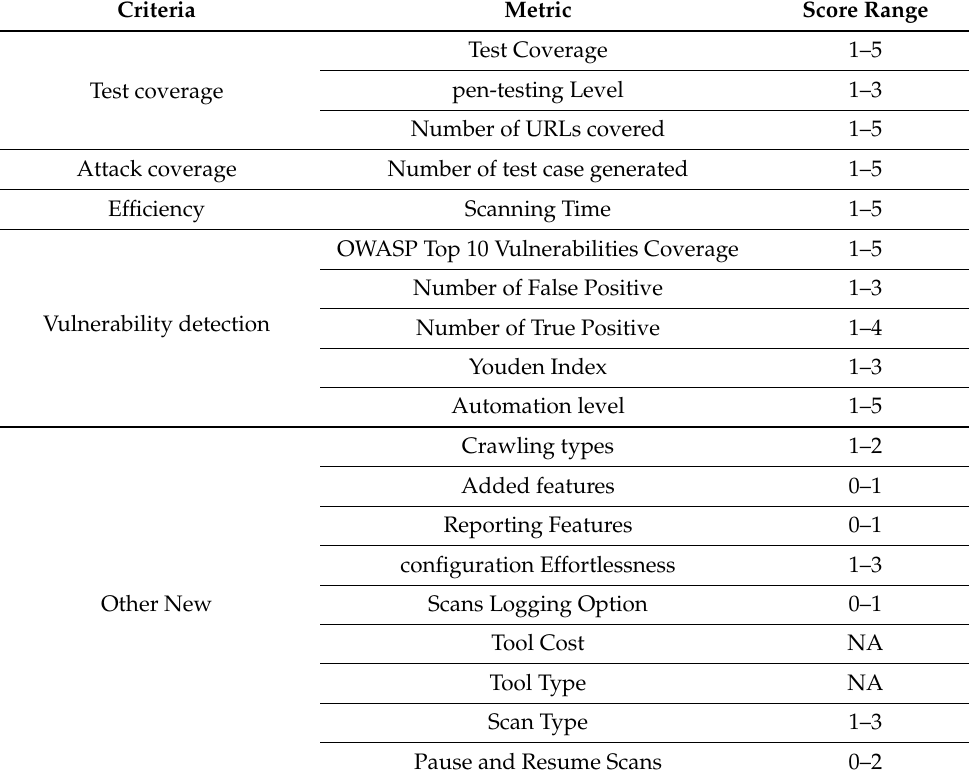
Table 2. Framework summary for Evaluation Criteria and Scoring